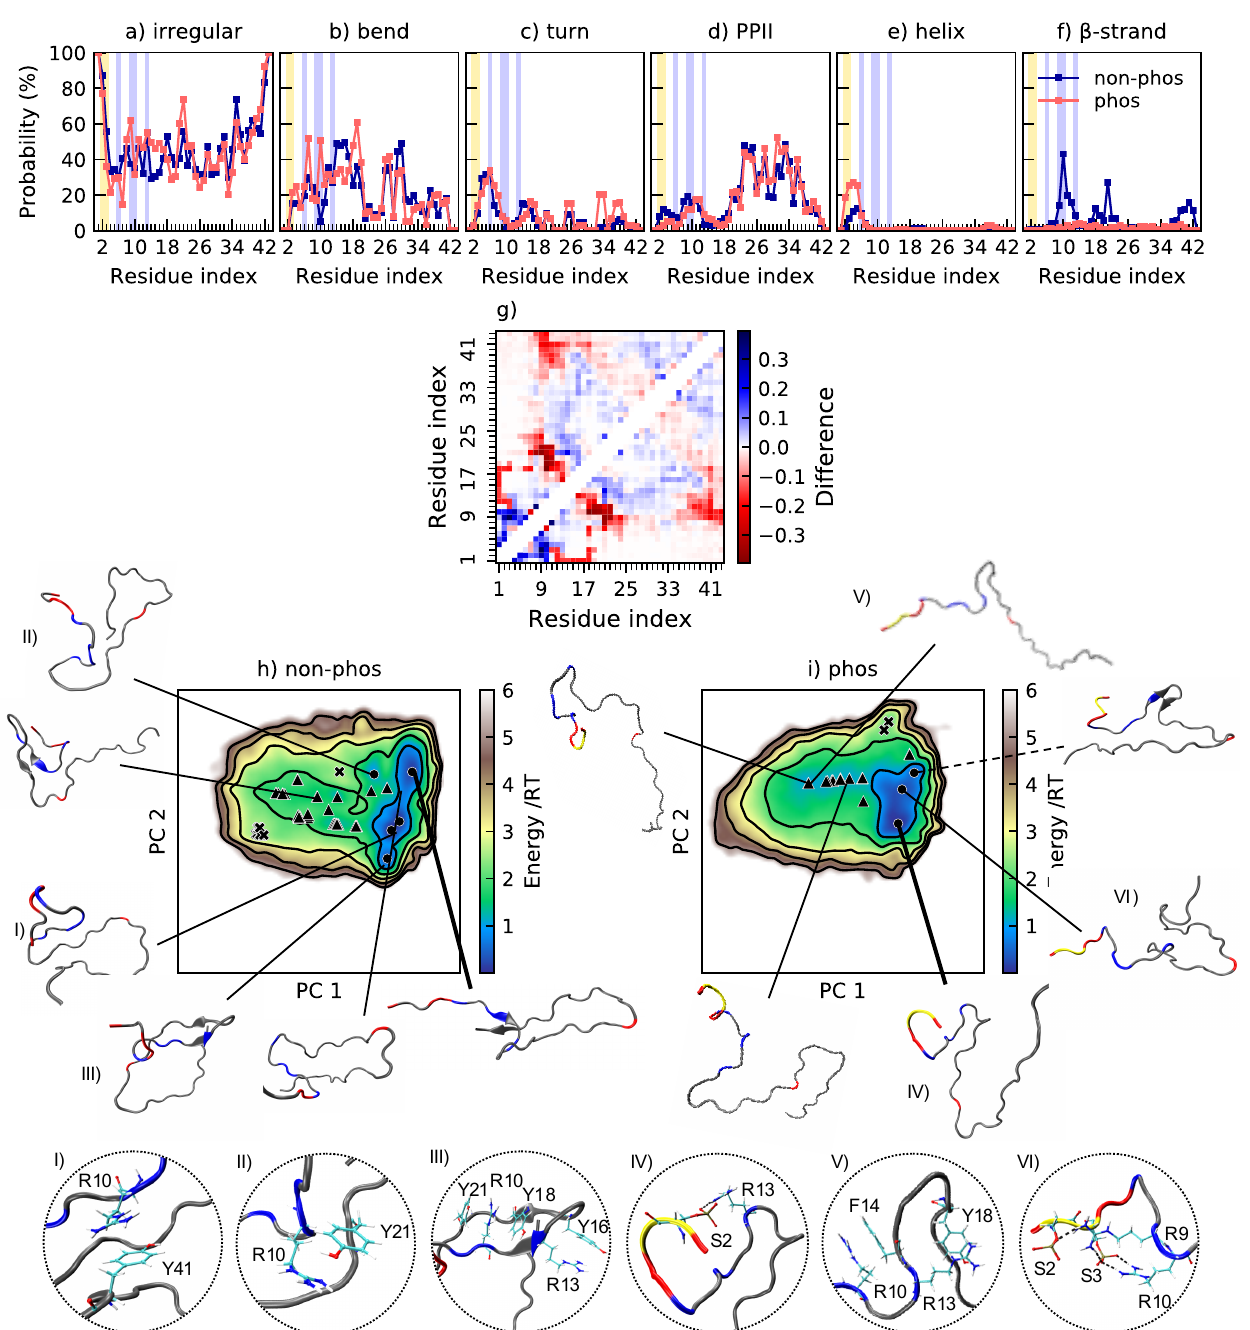
Figure 7. ( a – f ) Secondary structure content along the non-phosphorylated and phosphorylated sequence of Stath. Helix includes α -helix and 3 10 -helix. β -strand includes also β -bridge. The data for the phosphorylated peptide are previously published in [31]. The positions of phosphorylated and positively charged residues are highlighted in yellow and blue, respectively; ( g ) change in contact probability upon phosphorylation of Stath; ( h , i ) energy landscapes and conformations in minima of non-phosphorylated and phosphorylated Stath. The energy landscapes are constructed using the first two components from principal component analysis, using the same basis set for both variants, hence making them directly comparable. Contour lines are drawn for integer energy levels in the interval 1 ≤ RT ≤ 5 and the minimum of each basin is represented by a marker depending on the energy: (cid:108) : ≤ 1 RT , (cid:115) : ≤ 2 RT , (cid:54) : ≤ 3 RT . A thick line corresponds to the most populated basin, while a dashed line to the least populated basin. In the conformations, positively charged residues are shown in blue, negatively charged residues in red, and phosphorylated residues in yellow. The circles show specific interactions within the peptide in the conformations corresponding to the Roman